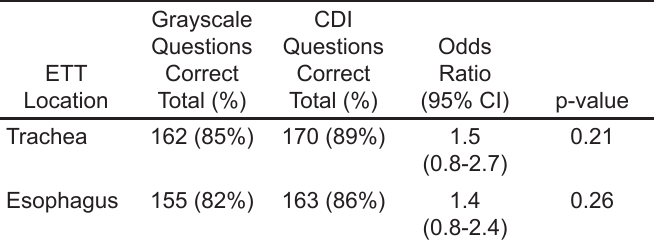
Table 2. Results of online quiz testing how accurately clinicians confirm ETT* placement when using grayscale vs color Doppler imaging techniques